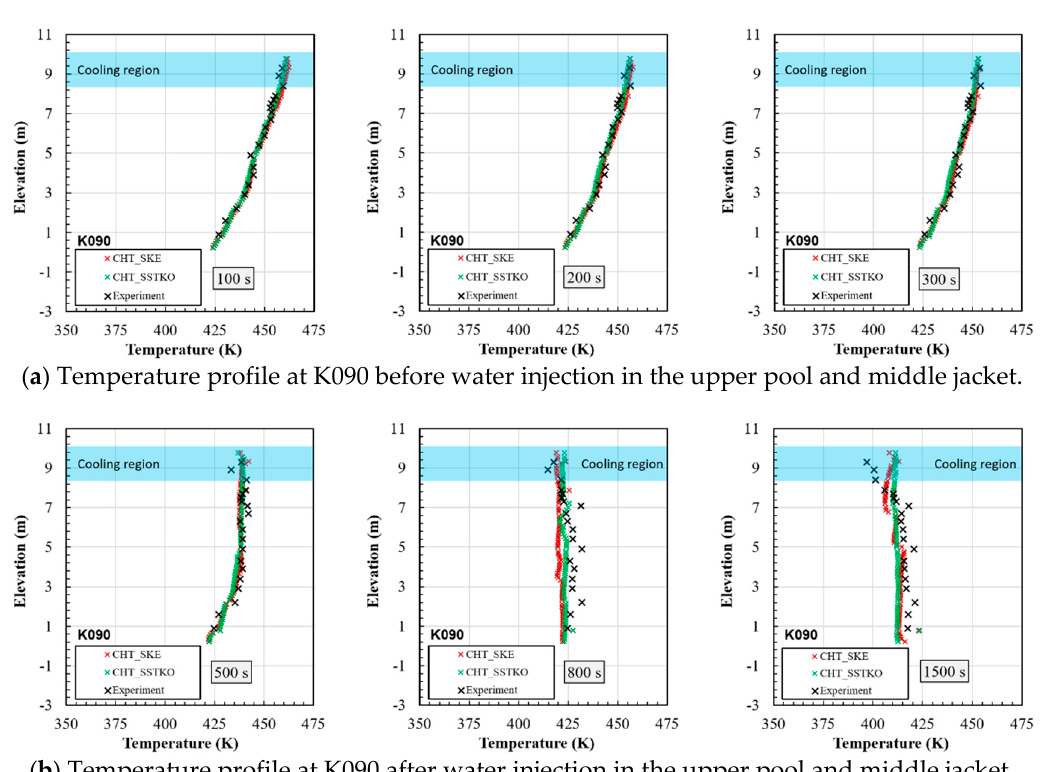
Figure 12. Influence of the turbulence model with conjugate heat transfer (CHT) on the temperature profile at K090.